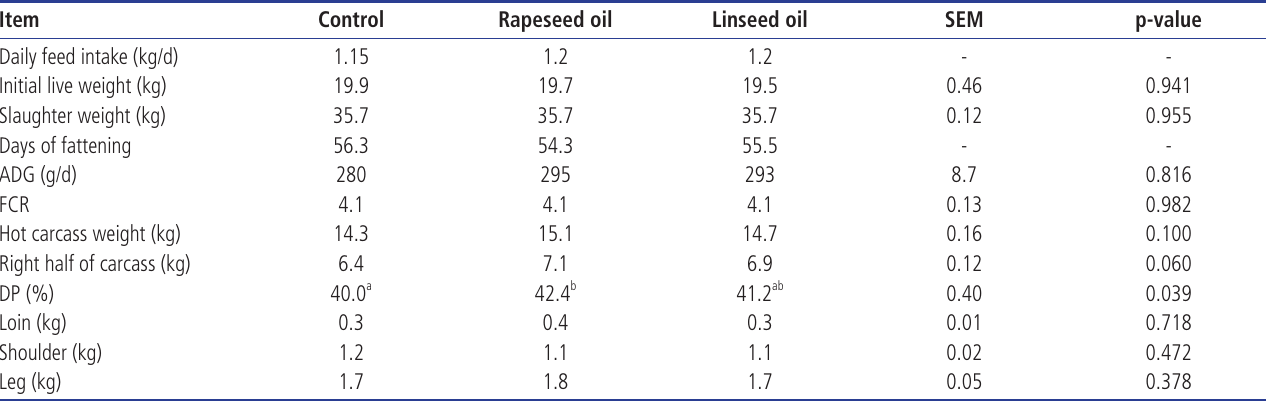
Table 3. Animal performance, carcass characteristic and carcass components of major cuts of lambs